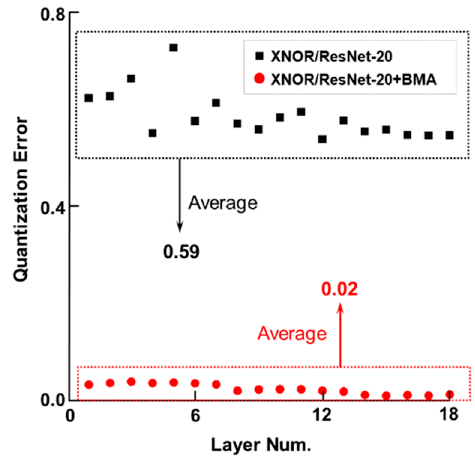
Figure 3. The quantization errors of network activations ( ± 95% confidence interval) with BMA (red) and without BMA (black) in binary pre-activation XNOR-Net/ResNet-20 model are illustrated. The models are trained on the CIFAR-10 dataset.